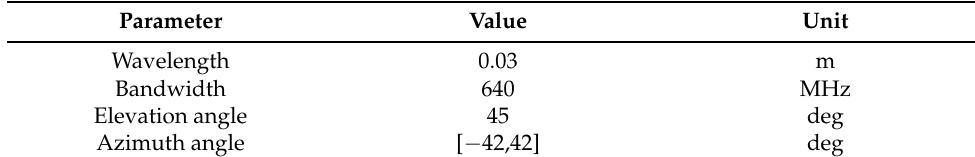
Table 6. Experimental parameters of publicly released airborne data.